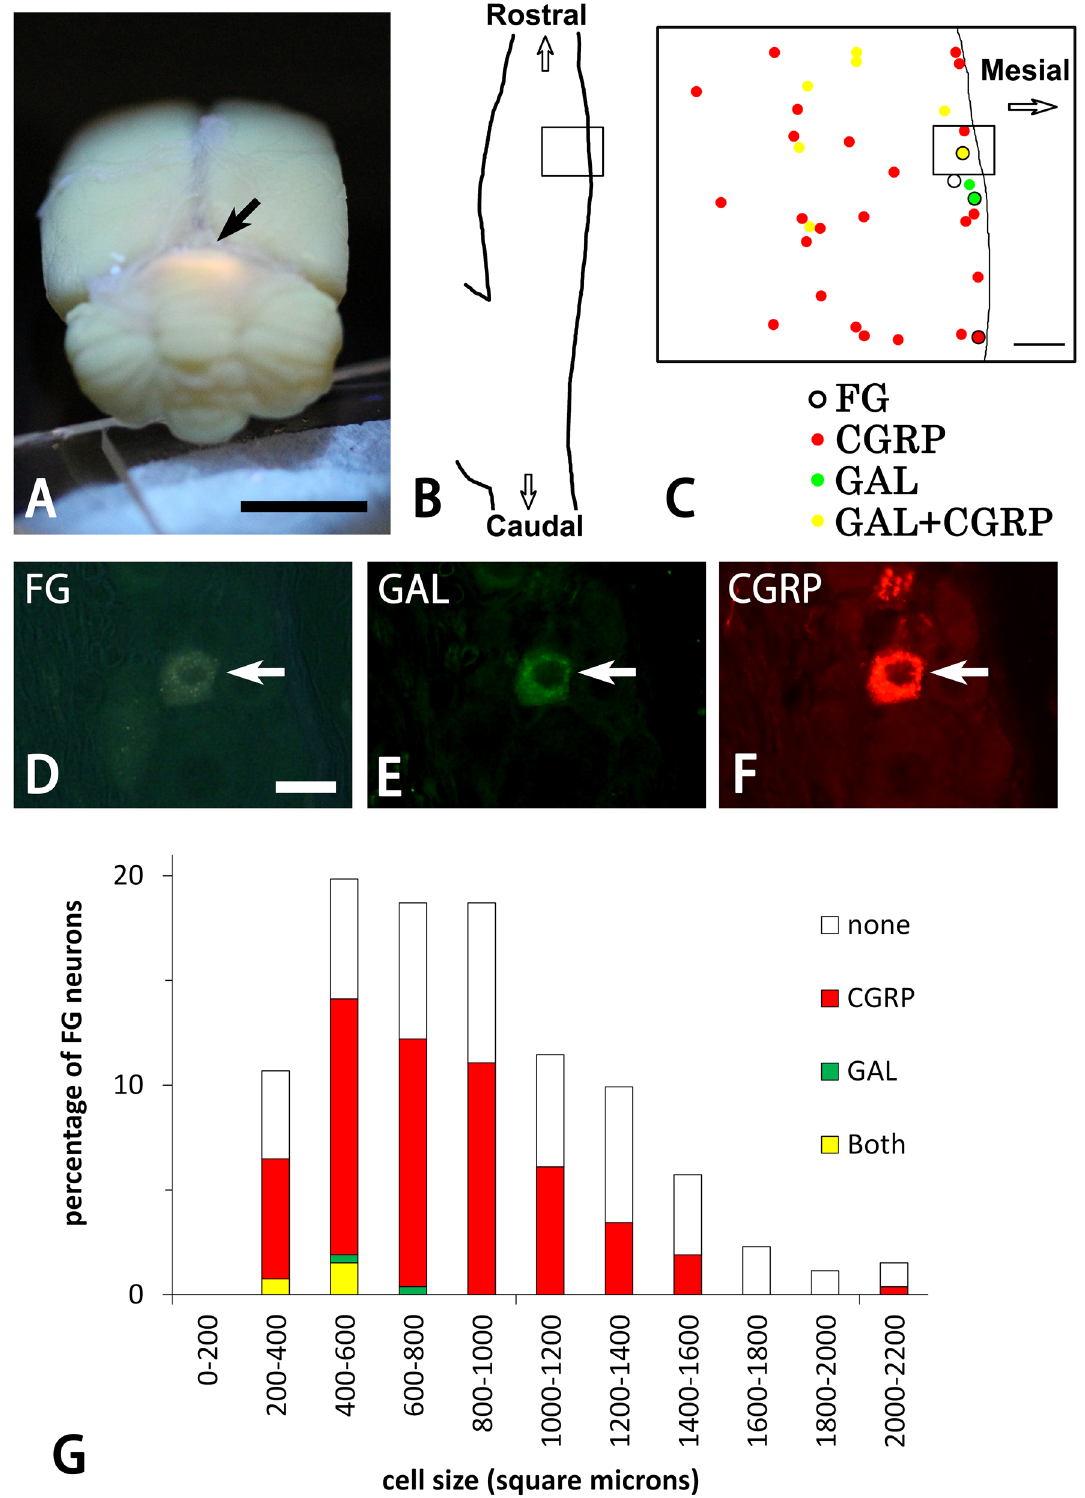
Figure 7. Photo for FG in the brain ( A ), schematic drawings of TG ( B , C ), and photomicrographs for FG ( D ), GAL ( E ), and CGRP ( F ) in the TG by a conventional fluorescence microscope ( A , D – F ). FG fluorescence is detected in the dorsal portion of the cerebellar tentorium (arrow in A ). Squares in ( B ) and ( C ) show the areas of panels ( C ) and ( D – F ), respectively. FG-positive neurons are mainly located in the ophthalmic region of the TG ( B , C ). These neurons contain GAL- and/or CGRP-immunoreactivity ( C ). Panels ( D – F ) are from the same field of view. A TG neuron retrogradely labeled with FG from the cerebellar dura mater (arrow in D ) contains both GAL- (arrow in E ) and CGRP-immunoreactivity (arrow in F ). Bars = 5 mm ( A ) and 20 µm ( D ). Panels ( D – F ) are at the same magnification. Bar graphs showing the cell size spectrum of FG-positive TG neurons with and without GAL- and CGRP- immunoreactivity. Data are obtained from 262 FG-positive TG neurons in four